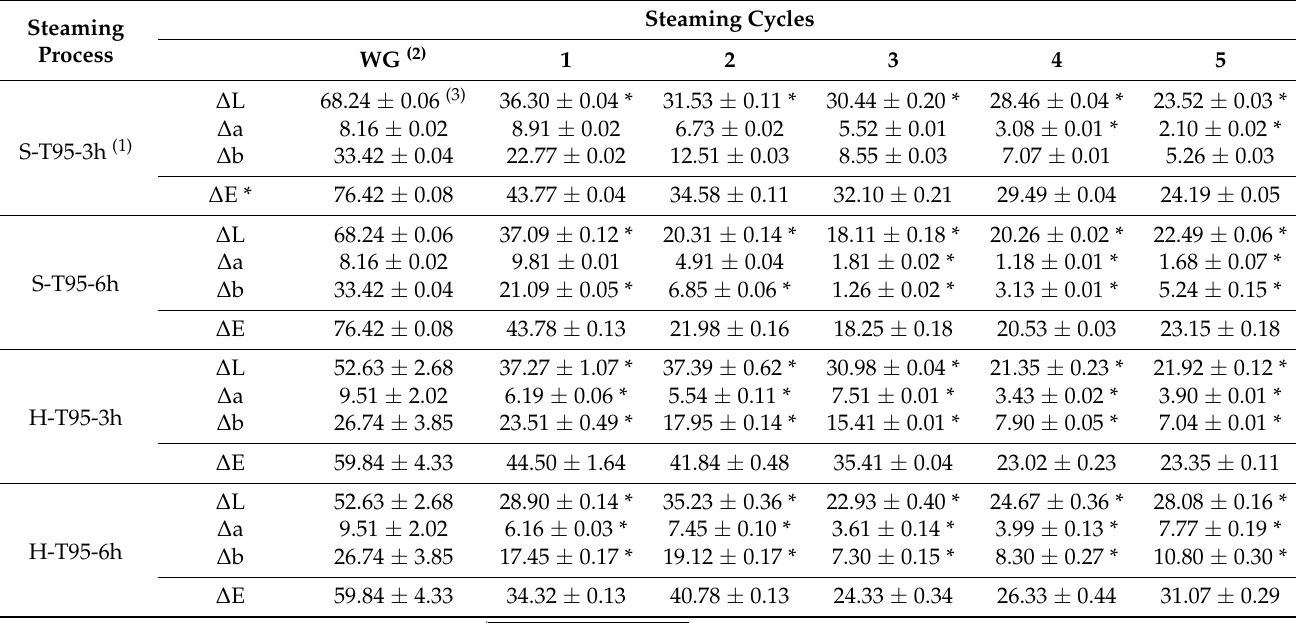
Table 1. Change in color difference values of black ginseng by number of steaming cycles.